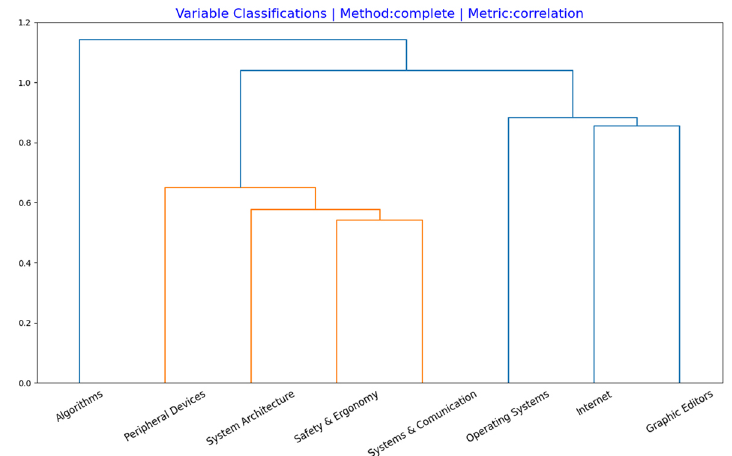
Figure 9. Hierarchical clustering of content domains variables based on individual